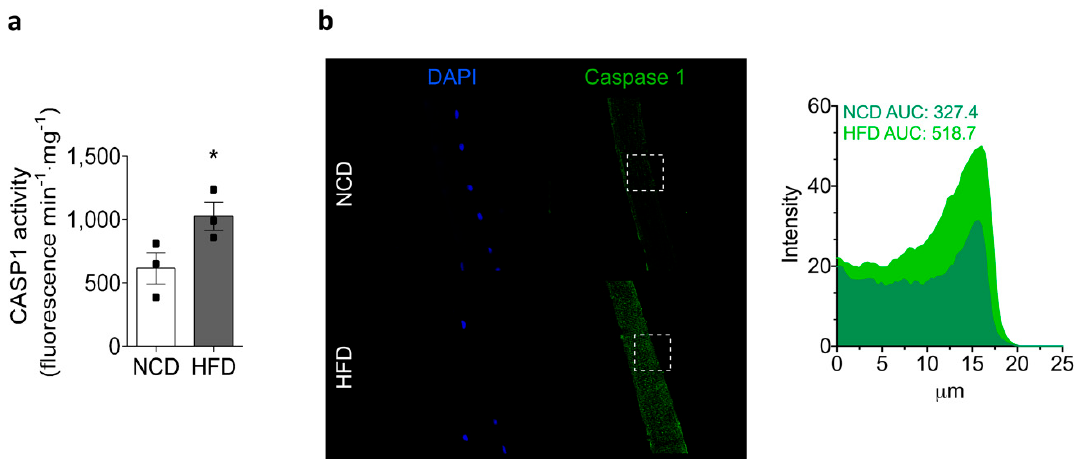
Figure 5. HFD increases caspase-1 activity in the skeletal muscle. Gastrocnemius muscles were collected from NCD- or HFD-fed mice, homogenized, and caspase-1 activity was measured. Values represent the mean ± SEM ( n = 3). * p < 0.05, determined by Student’s t -test. ( a ) Caspase-1 activity in muscle lysates was measured with a caspase-1 fluorometric kit. ( b ) Representative confocal images of isolated adult FDB fibers from NCD- and HFD-fed mice illustrate the localization of caspase-1 (green). Nuclei were stained with DAPI (blue). The area under the curve (AUC) was measured on white squares, and represented as fluorescence intensity. Scale bar: 20 μ m.